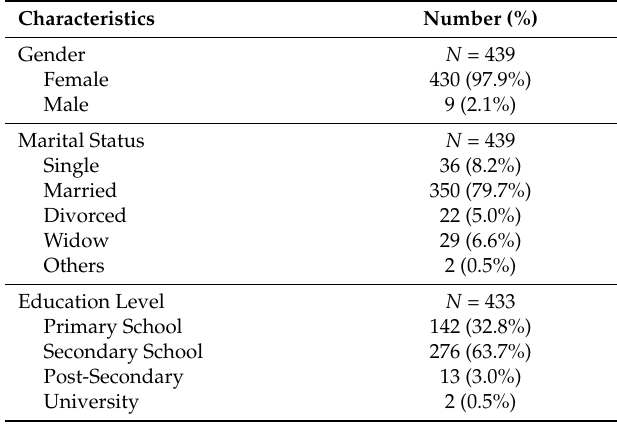
Table 1. Personal and work characteristics of nursing assistants (NAs) ( N =